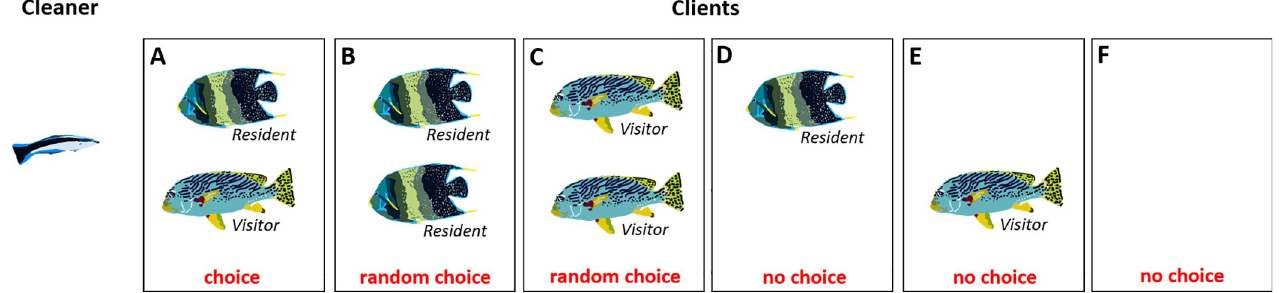
Fig 2. Model simulations. The cleaner in our simulations may encounter different combinations of client pairs awaiting its service: ( A ) the cleaner must choose between 2 clients of different types according to the model’s decision process; ( B and C ) the cleaner chooses with equal probabilities between 2 clients of the same type; ( D and E ) the cleaner serves the only available client; and ( F ) the cleaner waits for clients to visit its cleaning station.